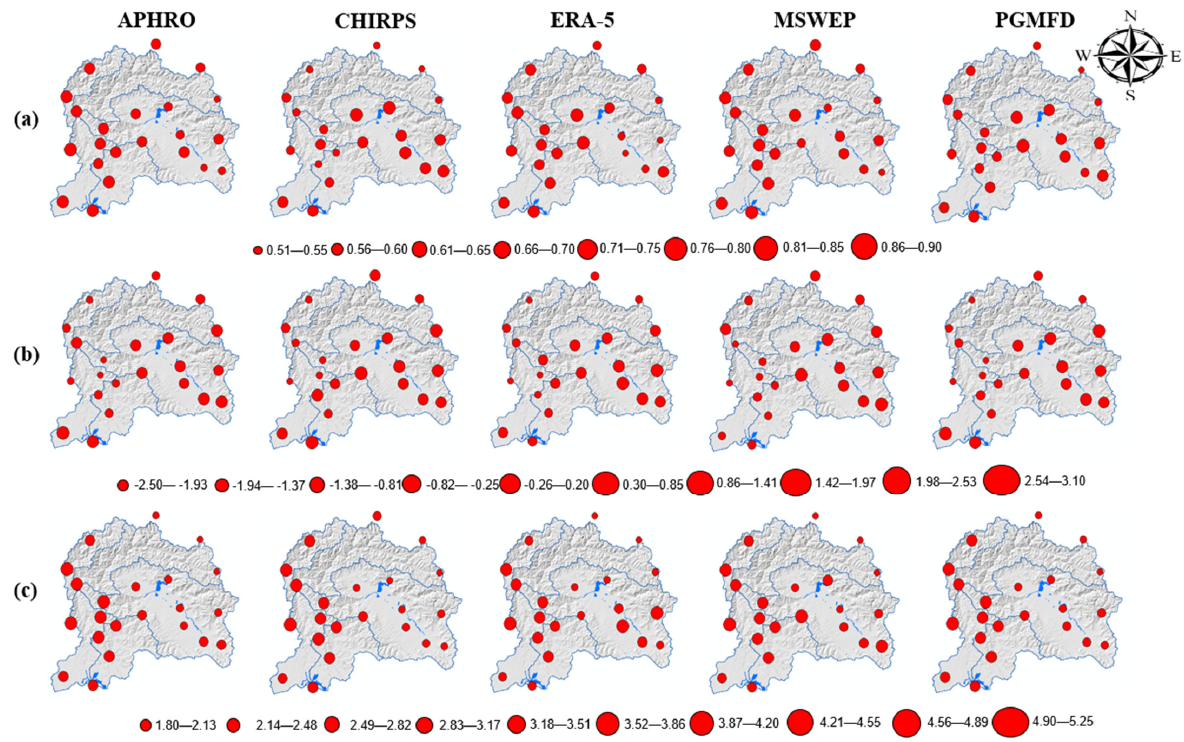
Figure 4. Spatial distribution of ( a ) CC, ( b ) Bias, and ( c ) RMSE from GPPs in contrast to in-situ gauge data during the entire study period. data during the entire study